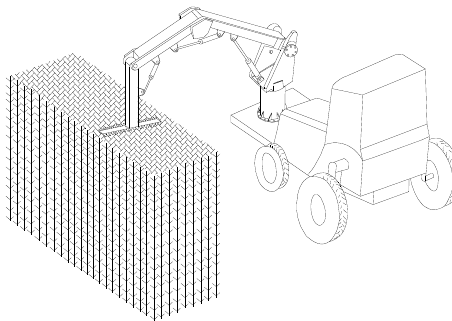
Figure 1. Manipulator trimming model .